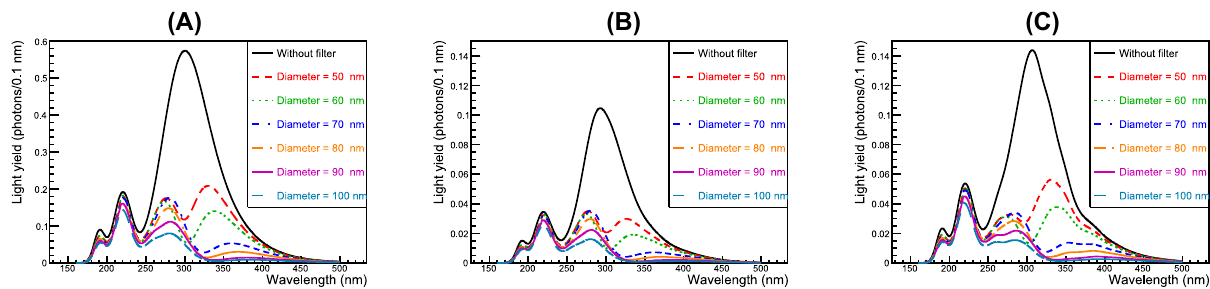
Figure 3: Emission spectra after being filtered using the proposed plasmonic filter: (A) ideal photodetector with perfect QE (100%), (B) multi-alkali photocathode, and (C) VUV SiPM. Choosing an optimal diameter of nanodisk enables suppression of slow components around 300